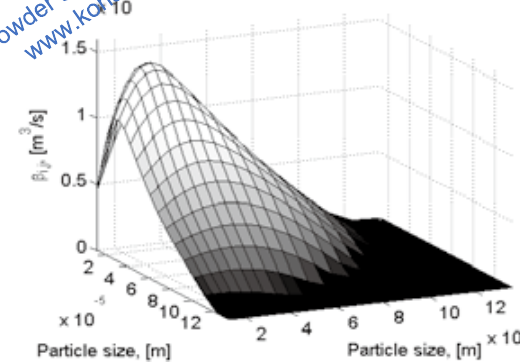
Fig. 3 Size-dependent efficient aggregation rate kernel. Size is given as the volume equivalent sphere diameter of the substitute ellipsoid. For better readability, the plot shows the rate kernel evaluated at the centre of each size interval. In the simulation, the discrete values on the intervals are